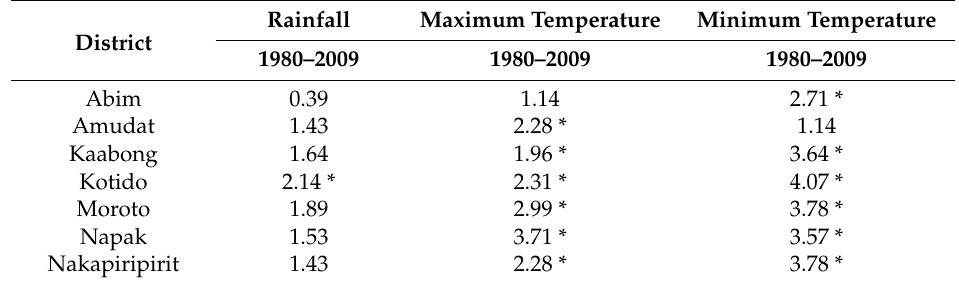
Table 2. Zs values of Mann–Kendall trend test analysis rainfall, minimum and maximum temperature. Rainfall Maximum Temperature Minimum District